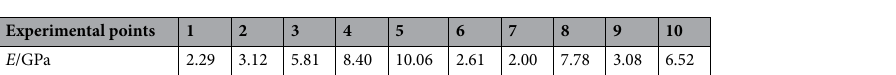
Table 3. Reduced moduli ( E ) defined at different locations for the veins in the models. The experimental points for the veins are the ten points marked with numbers 41 .